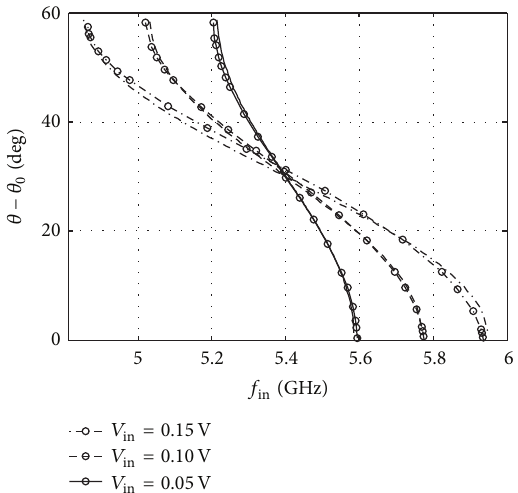
Figure 11: Phase difference between the input and output signals for thedivide-by-threeILFDinFigure 5with 𝐿 = 10 nHand 𝑅 = 905 Ω . SPICE simulations are obtained by using BSIM3 transistor models = 1.2 V, 𝑊/𝐿 = in MOSIS-IBM 8RF 0.13 𝜇 technology with 𝑉 𝑐 DD = 24/0.12 , 𝑊/𝐿 = 4.5𝑊/𝐿 𝑊/𝐿 . Analytical results are 𝑖 PMOS NMOS obtained by using